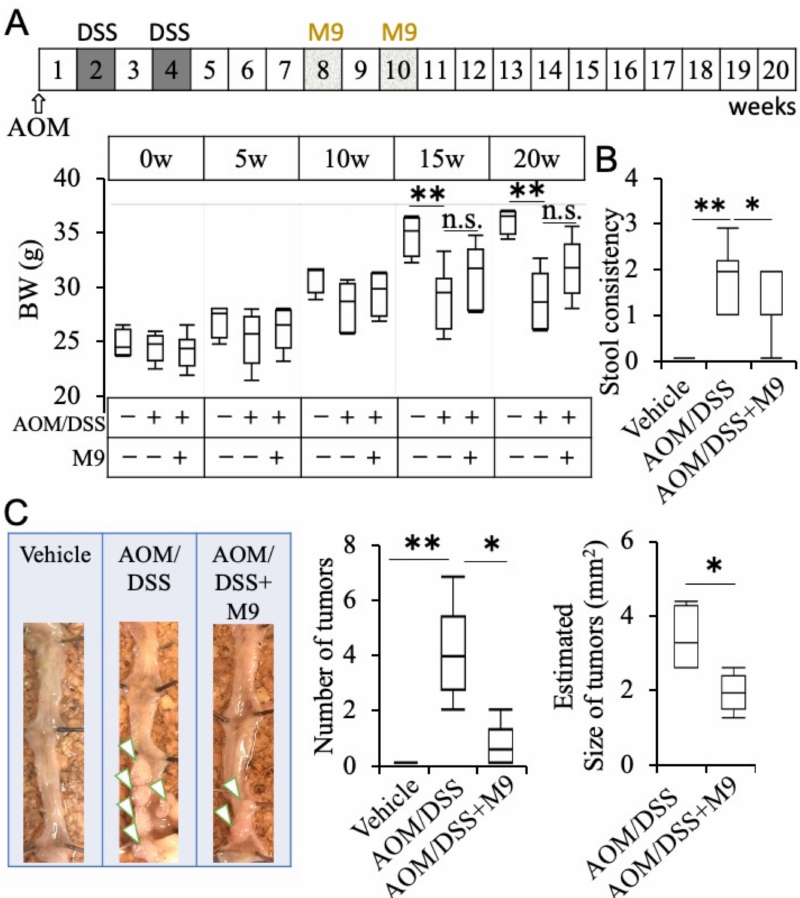
Figure 1. Treatment of Probio-M9 ameliorated azoxymethane/dextran sulfate sodium (AOM/DSS)- induced inflammation in a colitis-associated cancer (CAC) mouse model. ( A ) Treatment schedule and body weight (BW) changes for each group over the period of the experiment. Data are indicated in box-plot graphs. ( B ) Stool consistency score was interpreted as follows: 0, normal; 1, slightly loose stool; 2, severely loose stool; 3, diarrhea. ( C ) Representative images of colon morphology, total number of tumor, and estimated tumor size per mouse. n = 10. * p < 0.05; ** p < 0.01. n.s. means not significantly